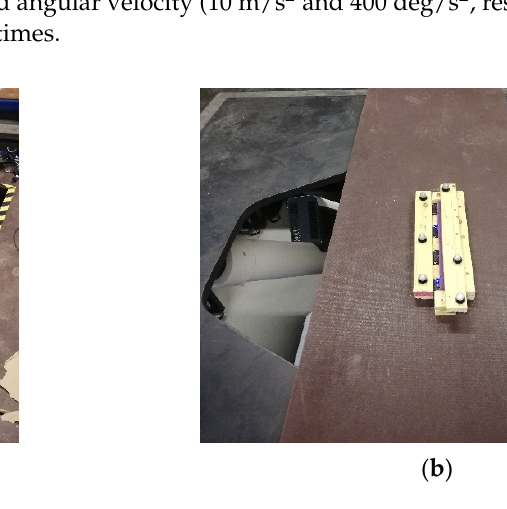
Figure 1. ( a ) Hydraulic hexapod. ( b ) IMUs and reflective markers.